Question: According to the figure, is the described quantity increasing or decreasing?
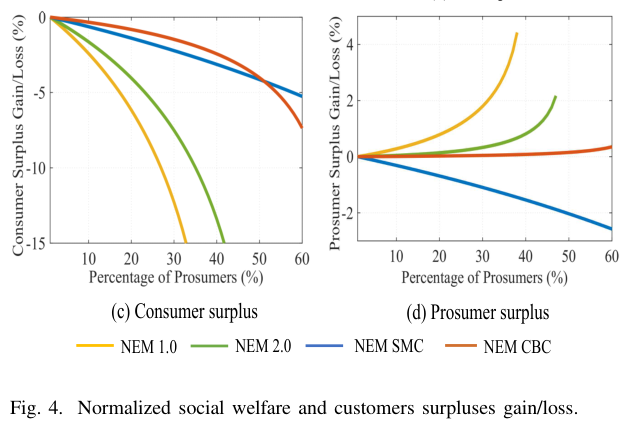
Answer: increasing